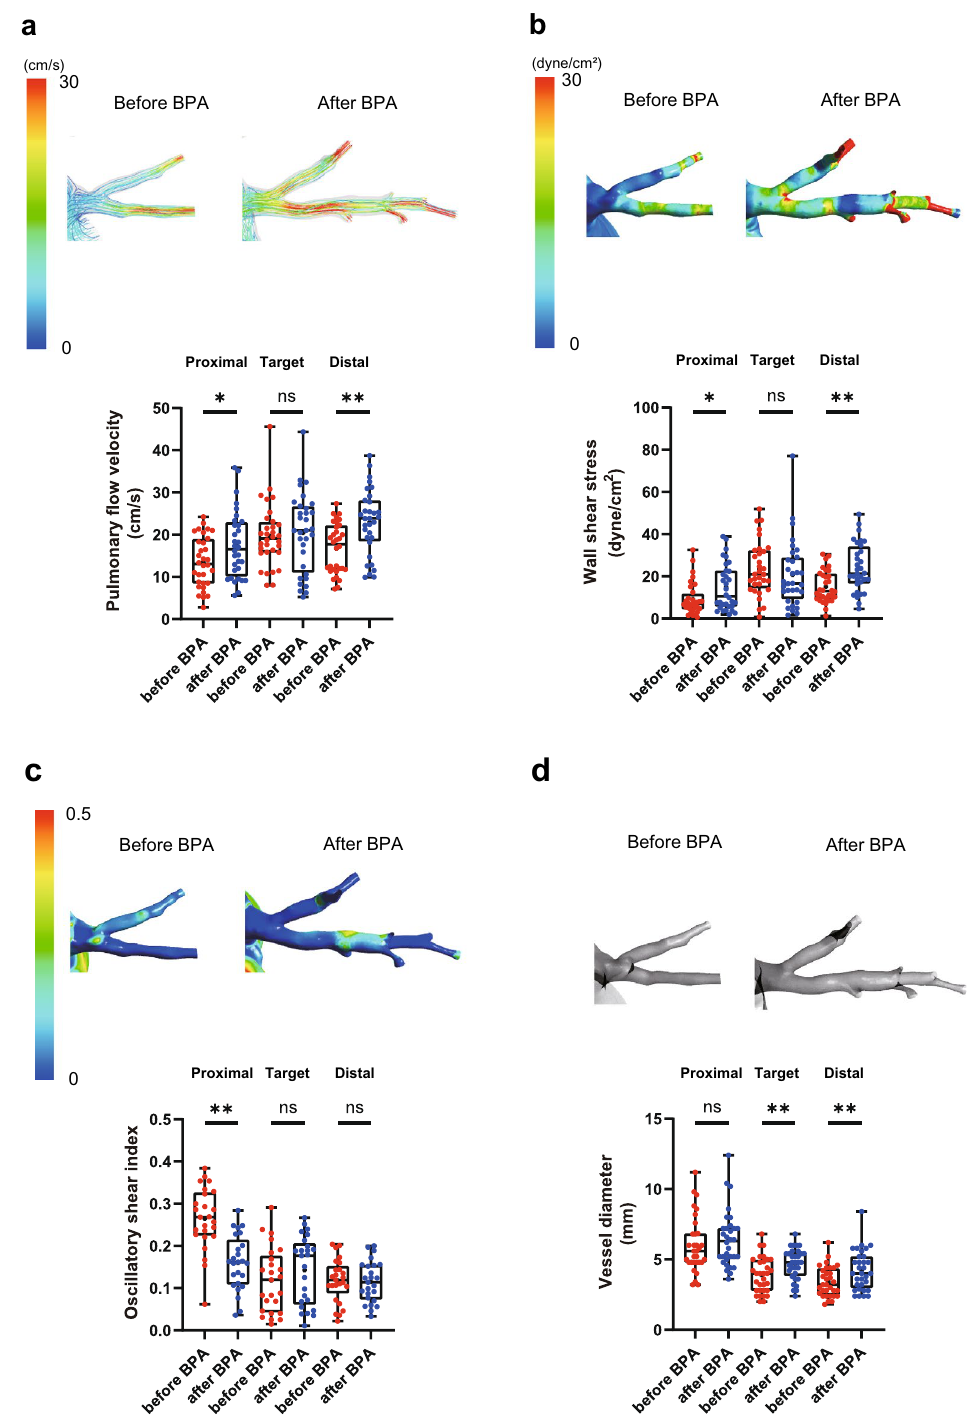
Figure 6. Local pulmonary blood flow dynamics in the pulmonary artery treated by BPA. Pulmonary flow velocity ( a ), wall shear stress ( b ), and oscillatory shear index ( c ) were simulated using CFD in the proximal portion, target lesion, and distal portion of the pulmonary artery branches treated with BPA. ( d ) The vessel diameters of the pulmonary arteries were measured before and after BPA. Data are presented as the median (interquartile range). Cross indicates mean. The numbers in each box plot indicate the sample size for each group. *p < 0.05 compared with before BPA; **p < 0.01 compared with before BPA; ns, not significant; BPA, balloon pulmonary